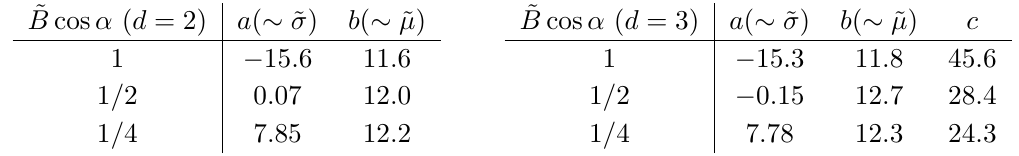
Table 1 . The numerically obtained coefficients in eqs. (4.11) and